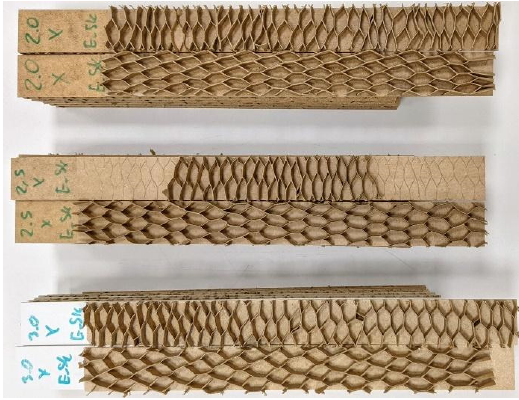
Figure 3. Examples of beams selected for testing. Table 3. Method of marking samples prepared for testing (The symbol * indicates the selected cell type, impregnation, facing type, orthotropy direction, climate condition).